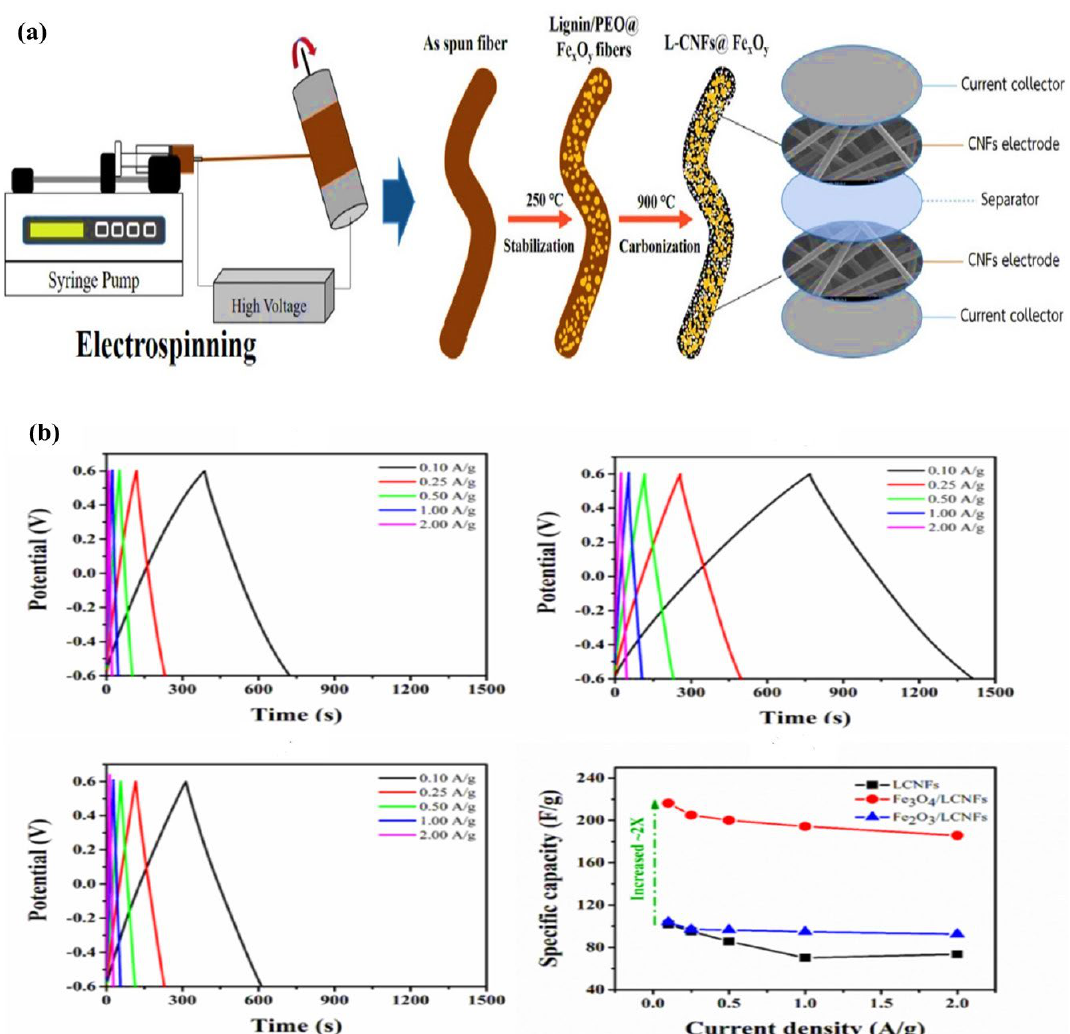
Figure 11. ( a ) Schematic illustration of the fabrication for lignin-CNF-Fe 3 O 4 composite. ( b ) Galvanostatic charge–discharge curves of L-CNFs, L-CNFs@Fe 3 O 4 , L-CNFs@Fe 2 O 3 , and plots of specific